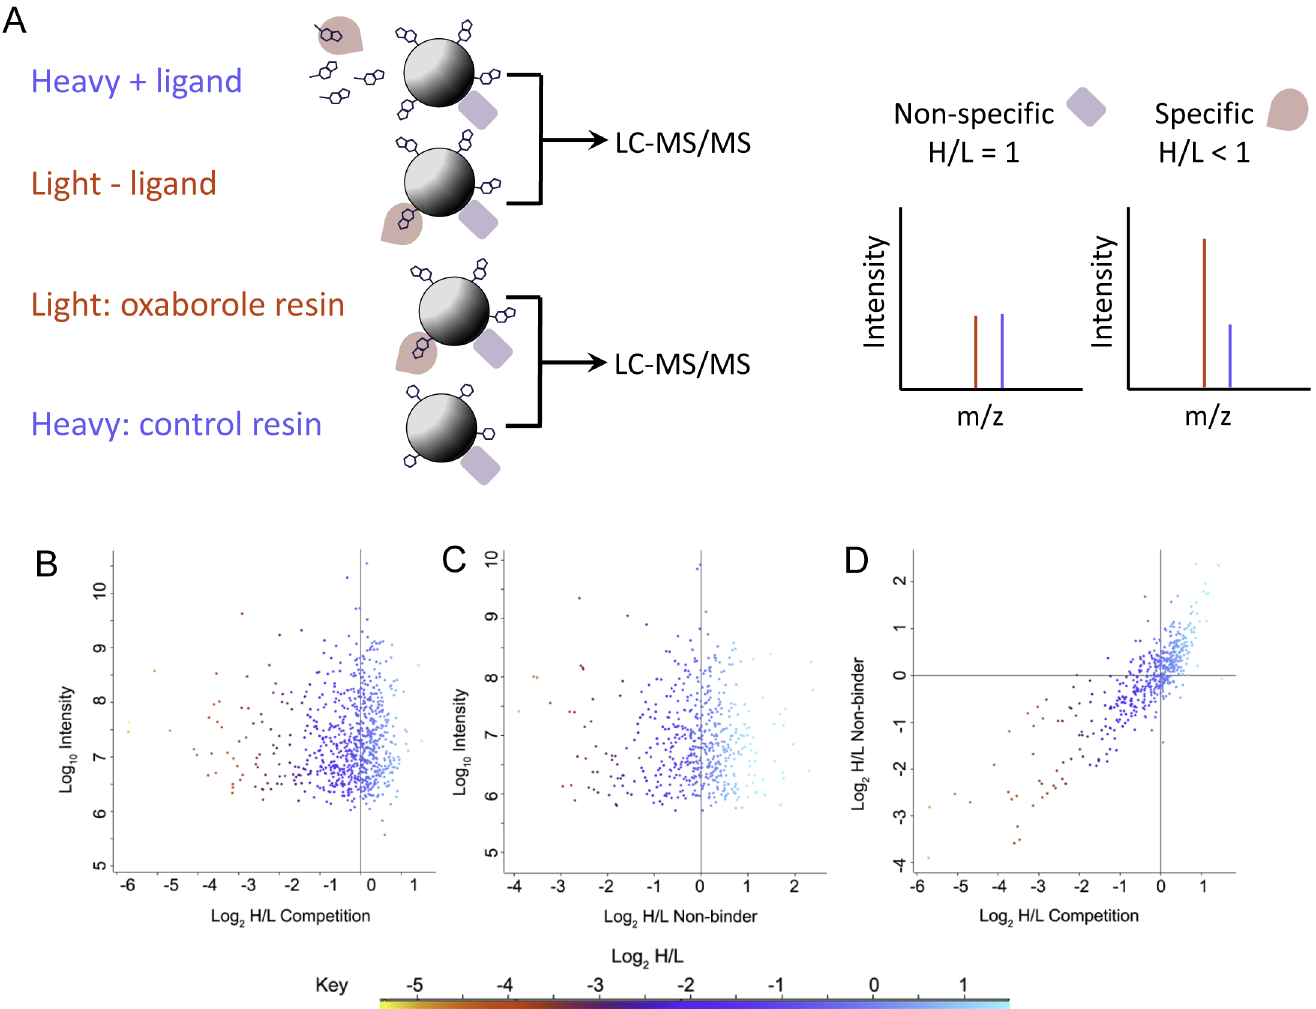
Fig 2. Quantitative chemical proteomic profiling of oxaborole targets. A – Schematic of proteomic profiling strategies representing ligand competition experiment (top) and resin comparison experiment (bottom). B – Drug competition experiment. SILAC-labelled T . brucei cell lysates were incubated with 10 μ M Oxaborole-1 (heavy label) or DMSO control (light label), prior to enrichment of protein with Oxaborole-Resin. C – Comparison of analogue-bound resin. Proteins were enriched from SILAC labelled T . brucei cell by Oxaborole-Resin (light label) or Control-Resin (heavy label). D – Correlation of the proteins quantified by the two strategies. A colour key is included to show the range of enrichment of identified